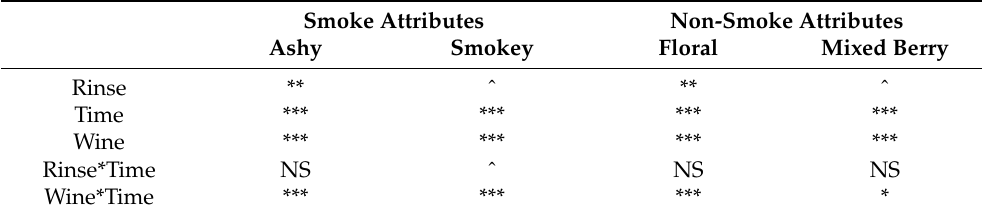
Table 3. Summary of the significance of random effects according to a three-way ANOVA from the intensity ratings at all time-points for all